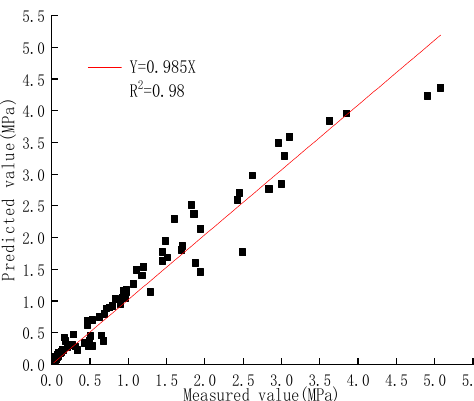
Figure 10. Comparison between the tested and predicted strengths.